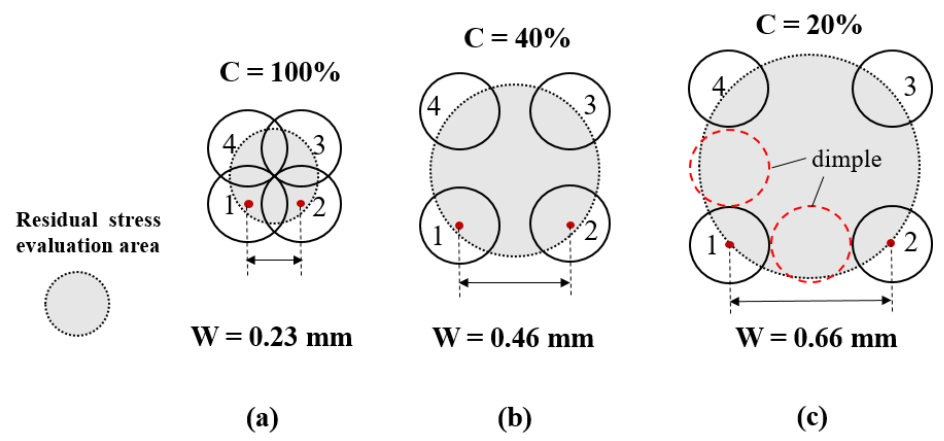
Figure 7. Schematic diagram of the horizontal distance between shots in 4-shots model: ( a ) W = 0.23 mm (C = 100%); ( b ) W = 0.46 mm (C = 40%); ( c ) W = 0.66 mm (C = 20%).